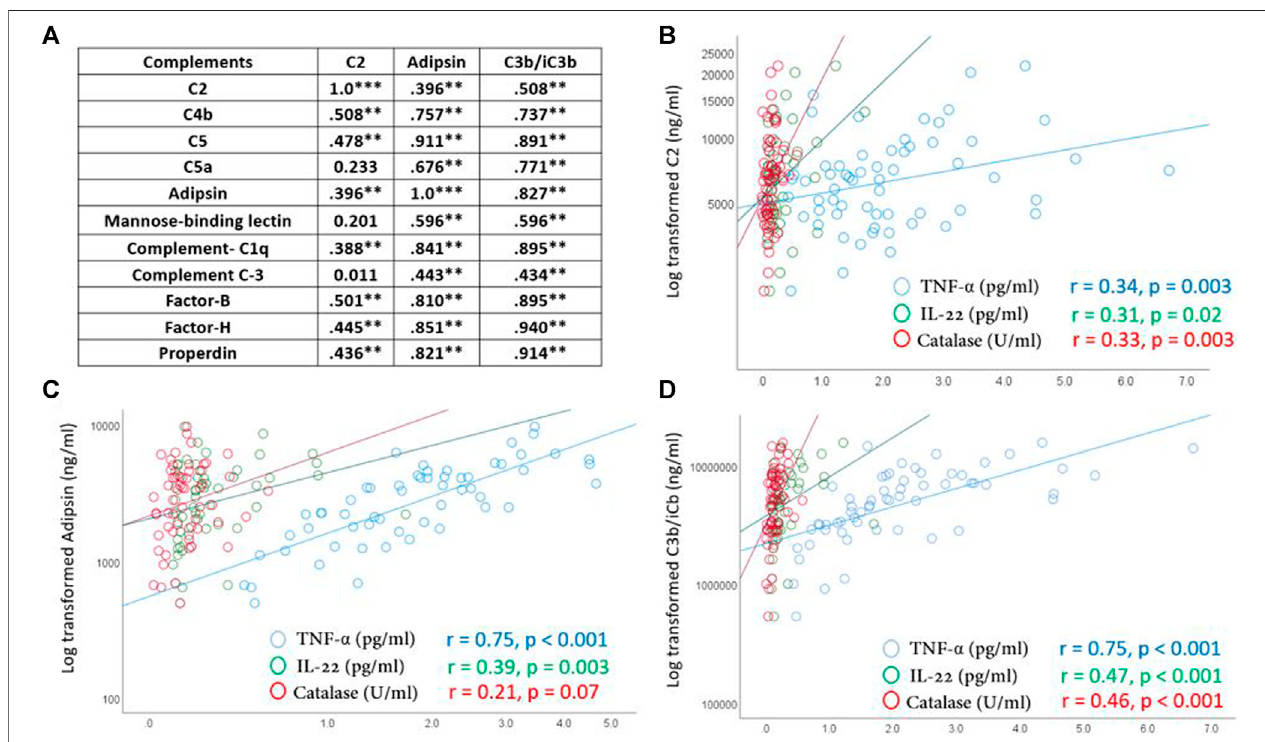
FIGURE 2 | Correlationsbetween C2,adipsin and C3b/iC3bcomplementsand other detected complements (A) and in fl ammatory cytokines and antioxidantenzyme catalase (B – D) . Correlations were made using spearman ’ s correlation analysis. Correlation coef fi cient (r) and signi fi cance (* p ≥ 0.05, ** p ≥ 0.01, *** p ≥ 0.001) are indicated.